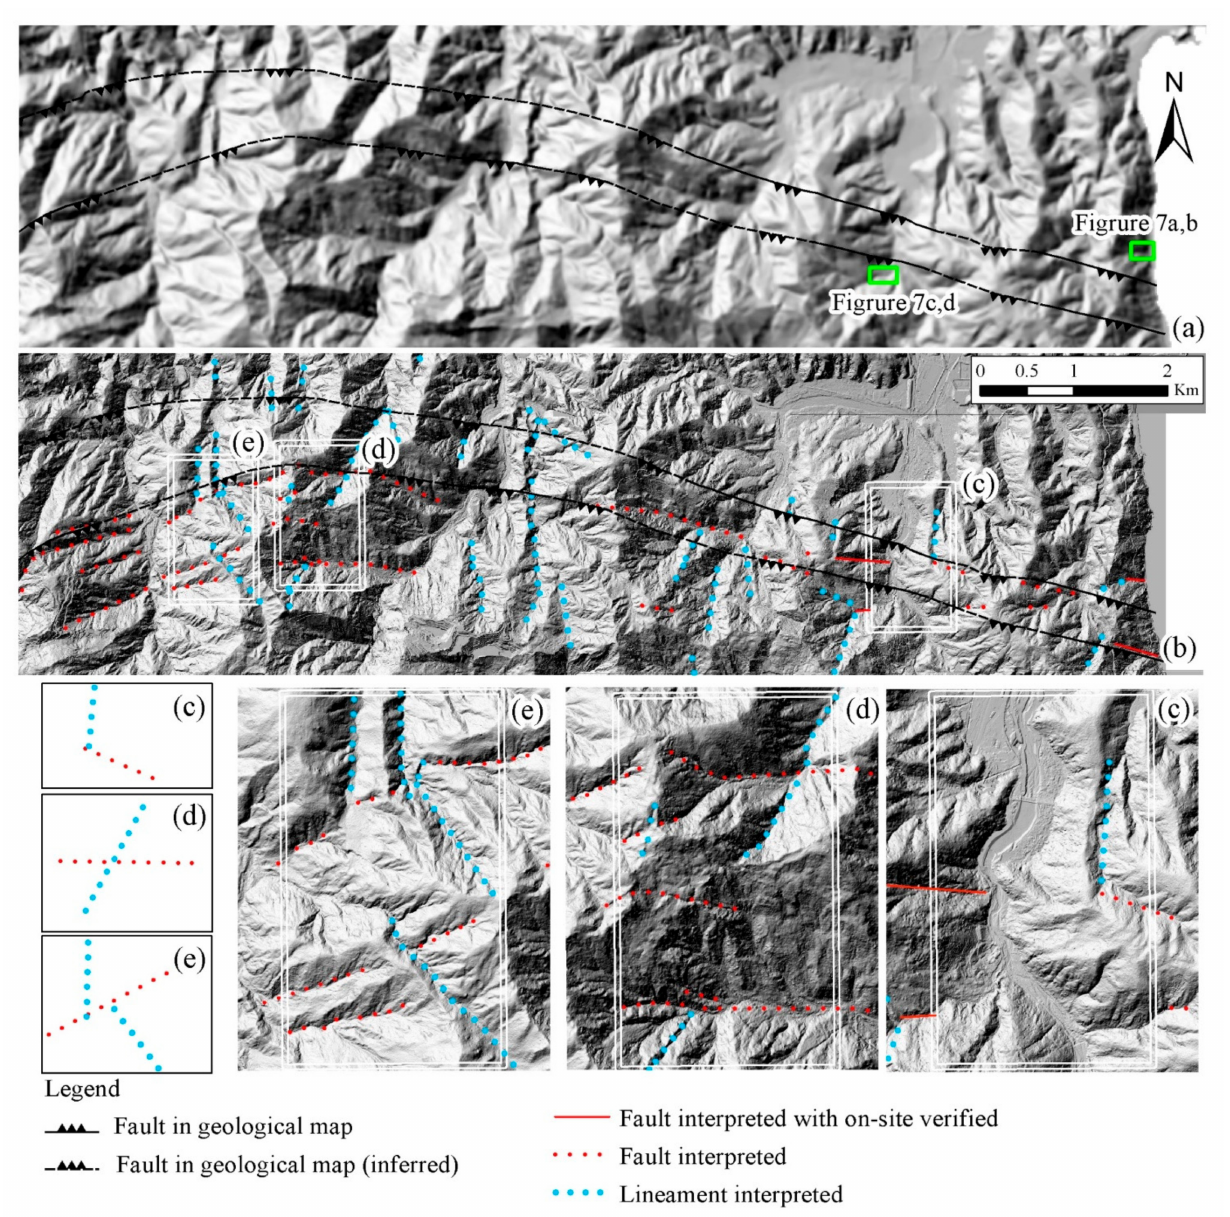
Figure 6. Hillshade map in vicinity of the Xiaomaoshan Fault and Houishan Fault, generated by 5 m- ( a ) and 1 m- ( b ) resolution DEMs. Sunshine direction was 315 ◦